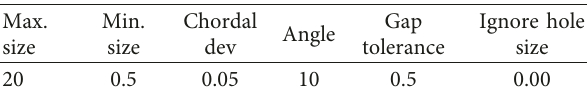
Figure 3: 3D model of the concave die. Table 1: Parameters of